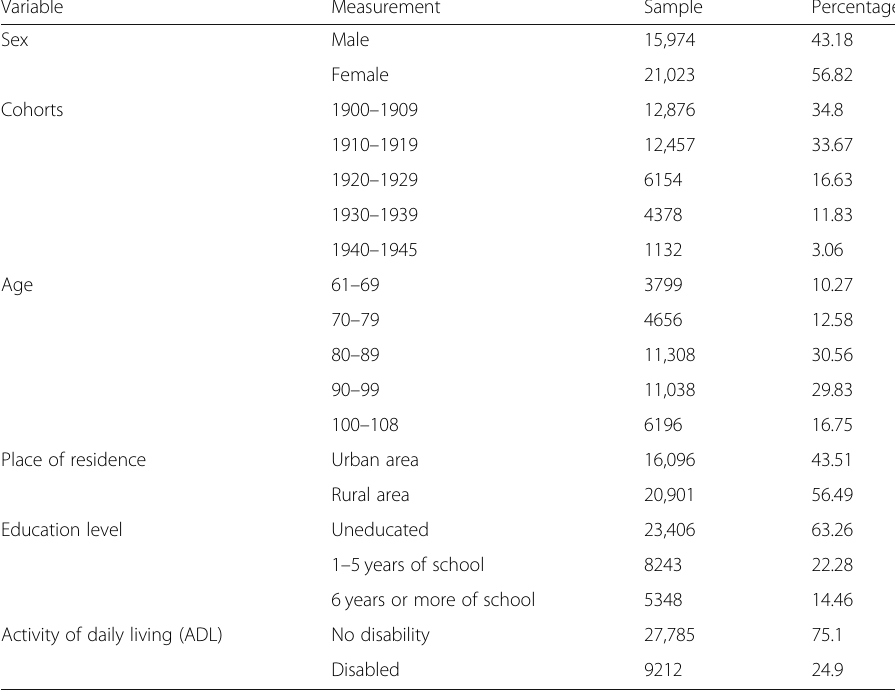
Table 2 The measurement of variables and the distribution information of the sample